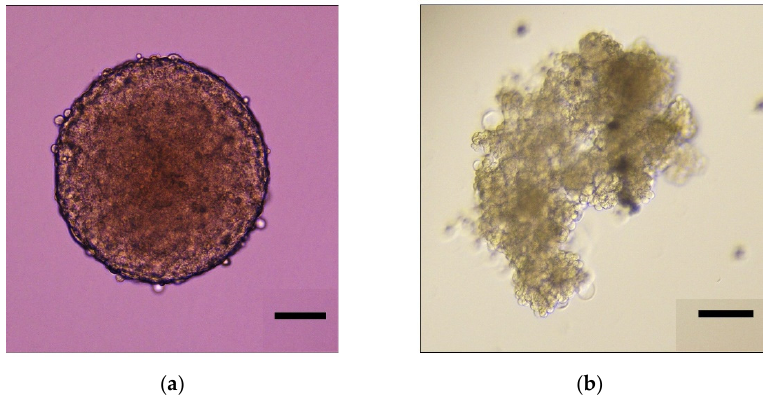
Figure 1. Representative images of 3D spheroid formation in ovarian cancer cell lines. Spheroids were grown until a diameter of ~400 µm. These images represent spheroids on day 0 prior to treatment with chemotherapy or epigenetic drugs. Scale bar is 100 µm. ( a ) Caov-3 spheroid; ( b ) Ovcar-3 spheroid.